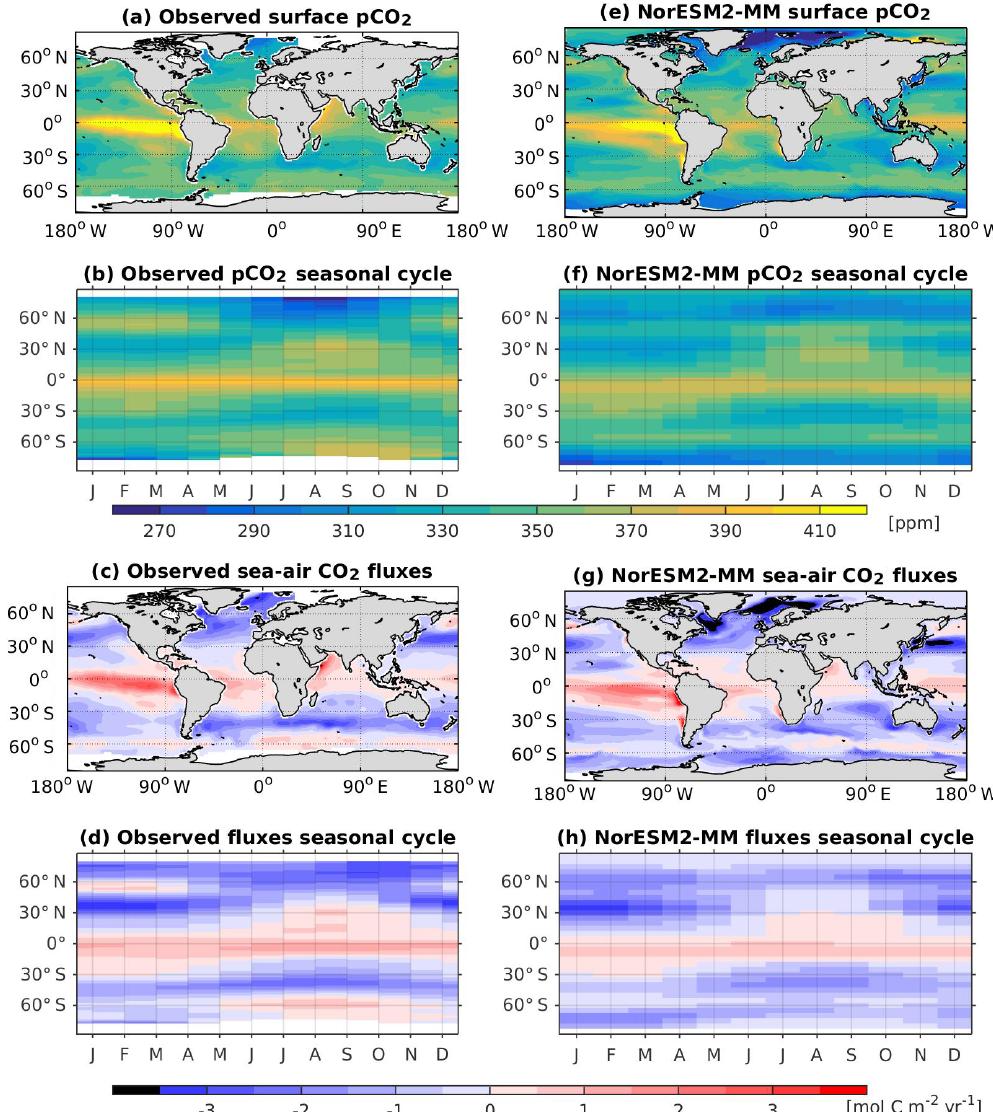
Figure 18. Observed surface climatology maps of (a) the partial pressure of CO 2 and (c) sea–air CO 2 fluxes together with Hovmöller plots of the zonally averaged seasonal cycle of (b) surface p CO 2 and (d) sea–air CO 2 fluxes. Corresponding values from the NorESM2-MM simulation are shown in panels (e–g)